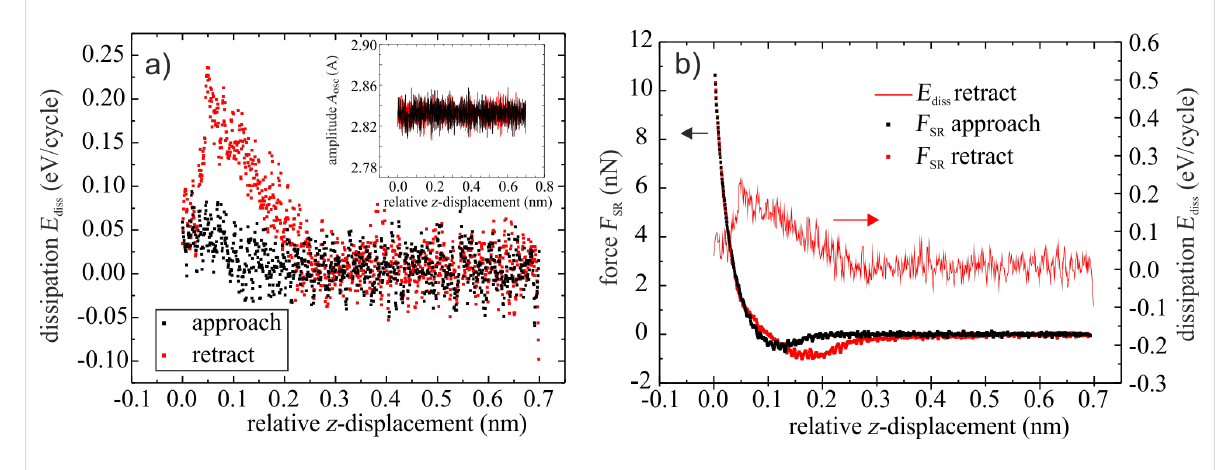
Figure 5: (a) Dissipation signal for approach (black dots) and retraction (red dots). The inset displays the simultaneously recorded oscillation ampli- tude. The maximum in the dissipation signal is found during the retraction. (b) Dissipation signal for the retraction together with the calculated force–distance